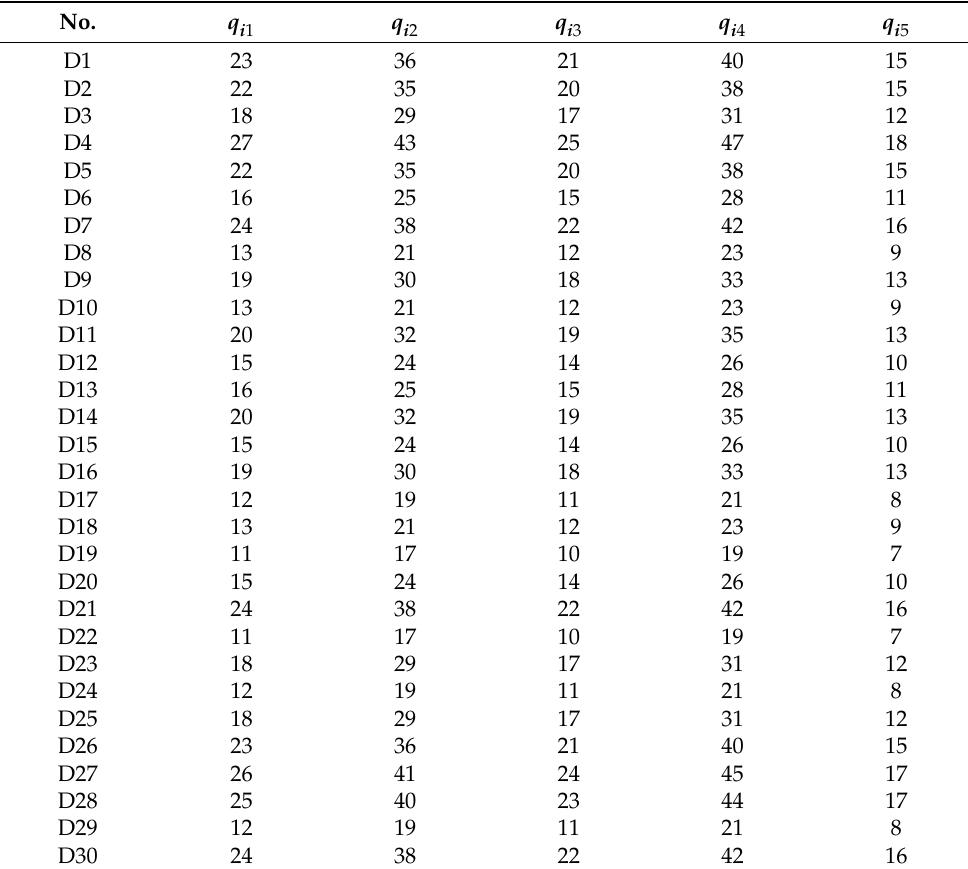
Table 3. Data on all demand